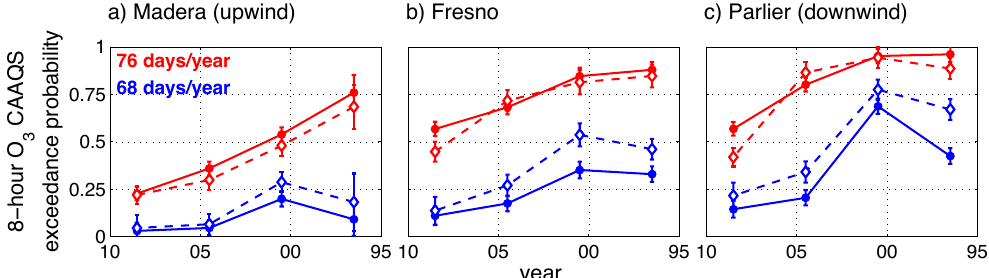
Fig. 7. Central SJV four-year median exceedance probabilities of the 8-h O3 CAAQS vs. year (increasing right to left) for Madera (a) , Fresno (b) , and Parlier (c) . Data are shown for 1995–1998, 1999–2002, 2003–2006, and 2007–2010 for high- (34–45 ◦ C) (red) and moderate- (28– 33 ◦ C) (blue) temperature regimes and divided into weekdays (closed circles) and weekends (open diamonds). Uncertainties are calculated as counting errors and are typically less than ± 0.04 (1 σ ) for weekdays and ± 0.06 (1 σ ) for weekends. Over the past sixteen years there were Figure 7. Central SJV four-year median exceedance probabilities of the 8-hour O on average 76 high-temperature days and 68 moderate-temperature days. year. Colors and symbols as in Figure 5. Over the past sixteen years there were on average 76 4 high-temperature days and 68 moderate-temperature days, 5